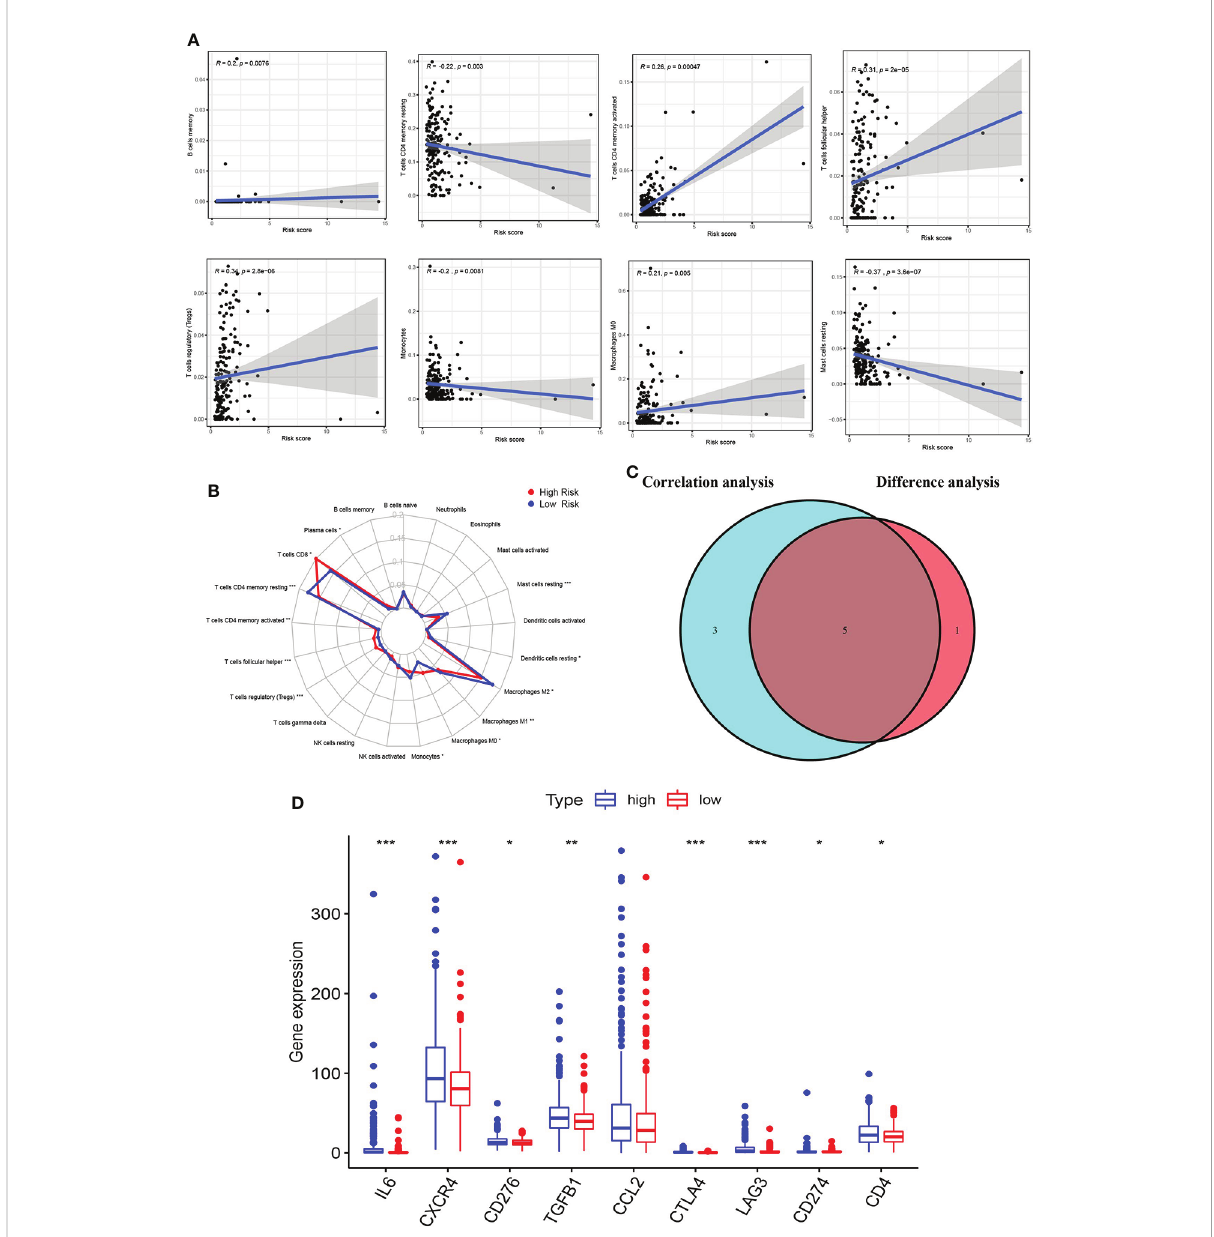
FIGURE 8 Correlation of immune microenvironment with risk score. (A) Scatter plot showing eight signi fi cantly correlated TICs (p < 0.01). The blue line in each plot was a fi tted linear model indicating the proportion of tropism of the immune cell along with risk score, and Pearson coef fi cient was used for the correlation test. (B) Radar plot showing differences in TICs between the high- and low-risk groups as measured by Wilcoxon rank- sum test. (C) Venn diagram showing that the 5 TICs were associated with the risk score jointly determined by the difference and correlation tests shown in the scatter and radar charts, respectively (p < 0.01). (D) Box plot showing the correlation between immune checkpoint and risk score. The meaning of the symbol *** is